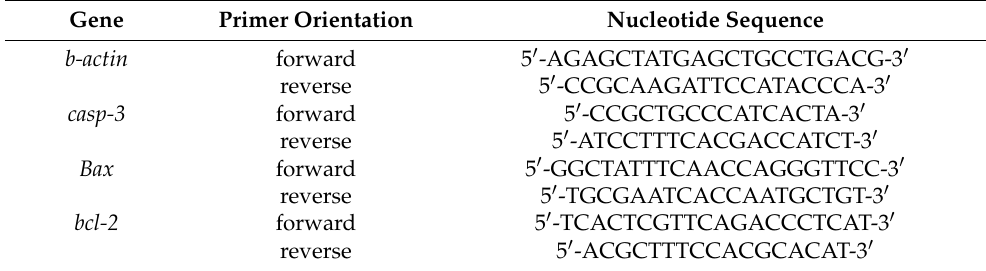
Table 1. Primers for real-time